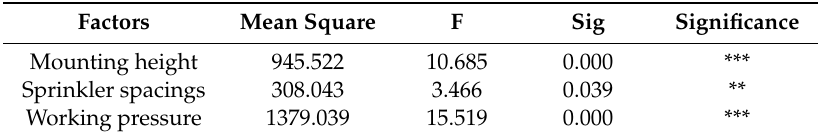
Table 5. Analysis of variance